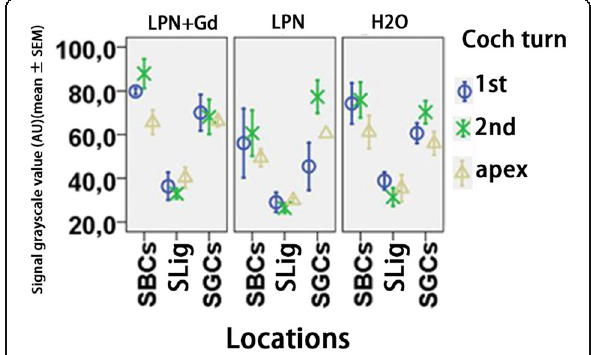
Fig. 12 Quantification of TLR2 protein level in rat cochlea exposed to liposome nanocarriers detected using immunofluorescent confocal microscopy. There was insignificant difference among groups ( p >0.05, one-way ANOVA). n =3 in each group. AU arbitrary unit, H2O negative control, LPN empty liposome nanocarrier, LPN+Gd Gd-DOTA-containing LPN, SBCs stria basal cells, SGCs spiral ganglion cells, SLig spiral ligament, 1st basal turn, 2nd second